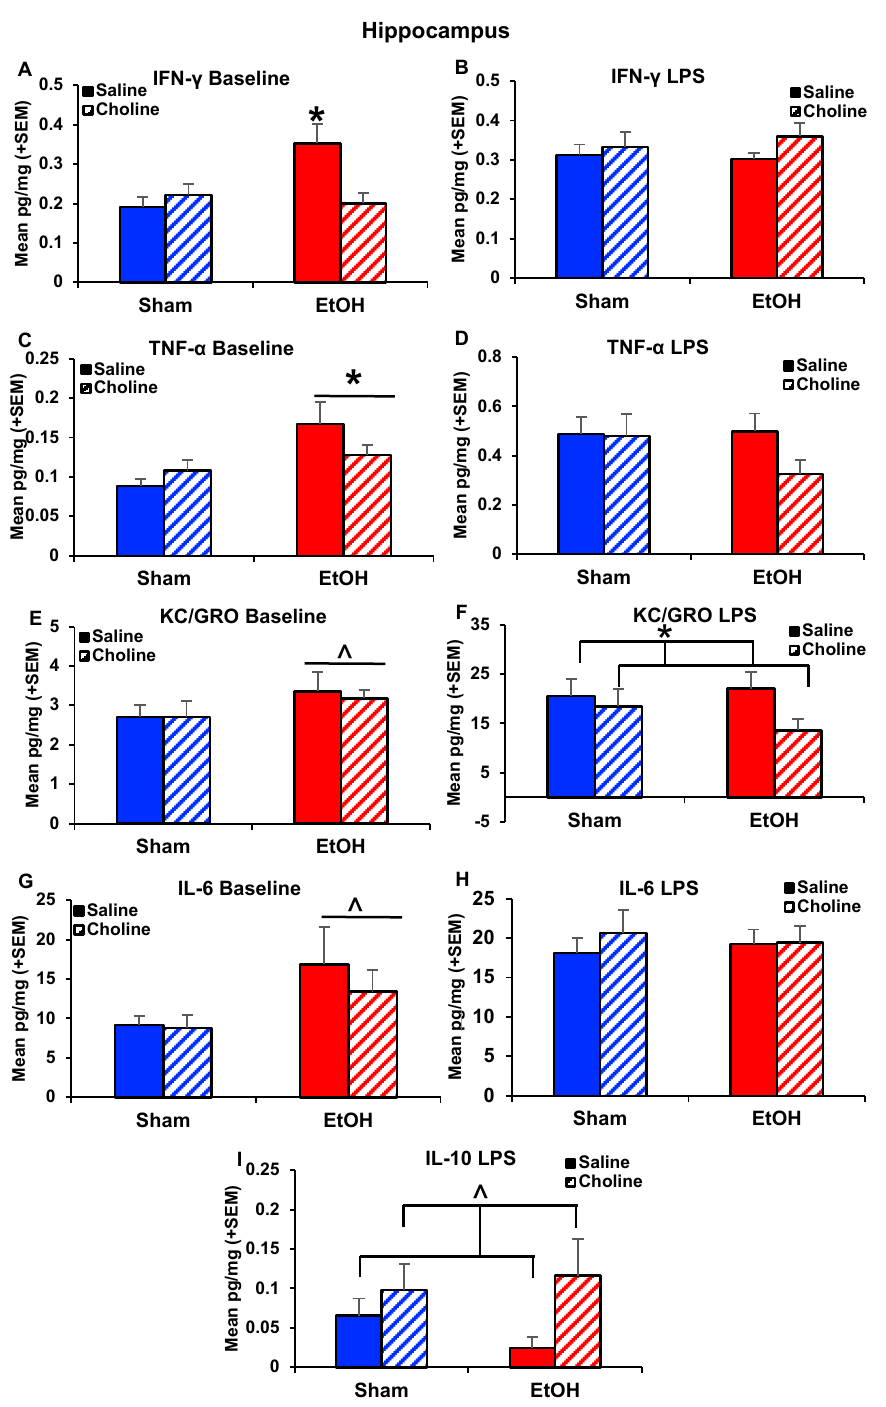
Figure 3. Hippocampal cytokine levels at baseline and following immune challenge of LPS. The following hippocampal cytokines are depicted in the graphs above: ( A ) Baseline IFN- ɣ (EtOH + Choline < EtOH + Saline, * p < 0.05), ( B ) LPS IFN- ɣ , ( C ) Baseline TNF- α (EtOH > Sham, * p < 0.05), ( D ) LPS TNF- α , ( E ) Baseline KC/GRO (EtOH > Saline, ˆ p < 0.10), ( F ) LPS KC/GRO (Choline < Saline, * p = 0.05), ( G ) Baseline IL-6 (EtOH > Saline, ˆ p < 0.10), ( H ) LPS IL-6, and ( I ) LPS IL-10 (Choline > Saline, ˆ p < 0.10). n = 19–24 per